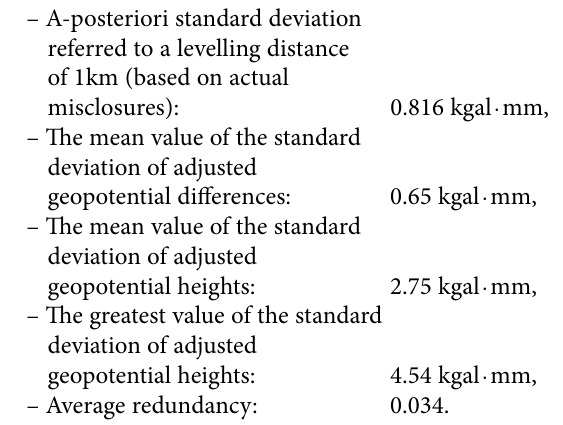
Table 7. Misclosures of the connecting loops Loop Loop